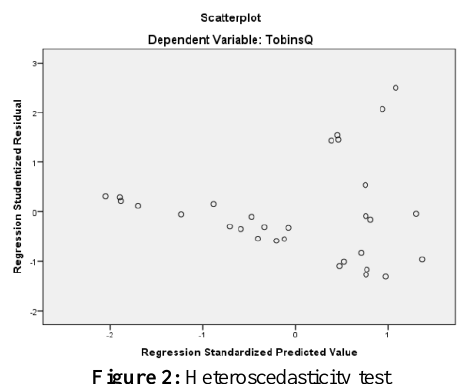
Figure 2: Heteroscedasticity